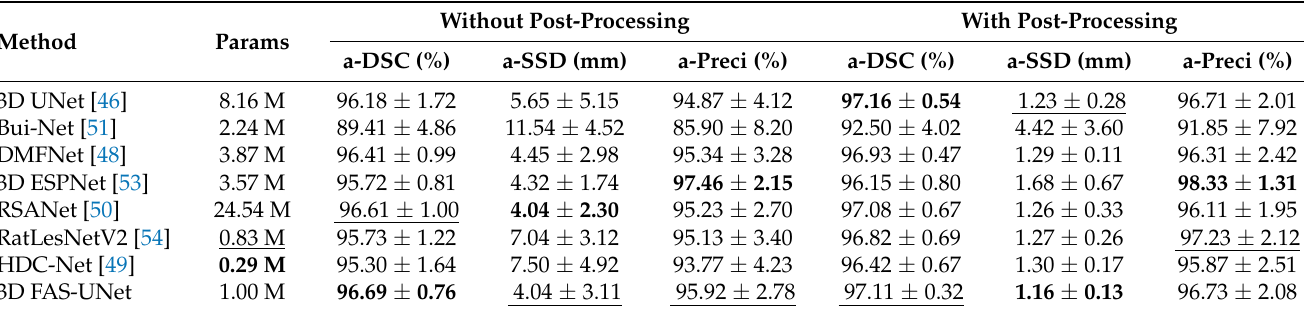
Table 9. Performance comparisons of liver segmentation between the different 3D networks with/without post-processing using the a-DSC, a-SSD, and a-Preci values on the 3D CHAOS-CT vali- dation datasets. The best and second places are highlighted in bold font and underlined,